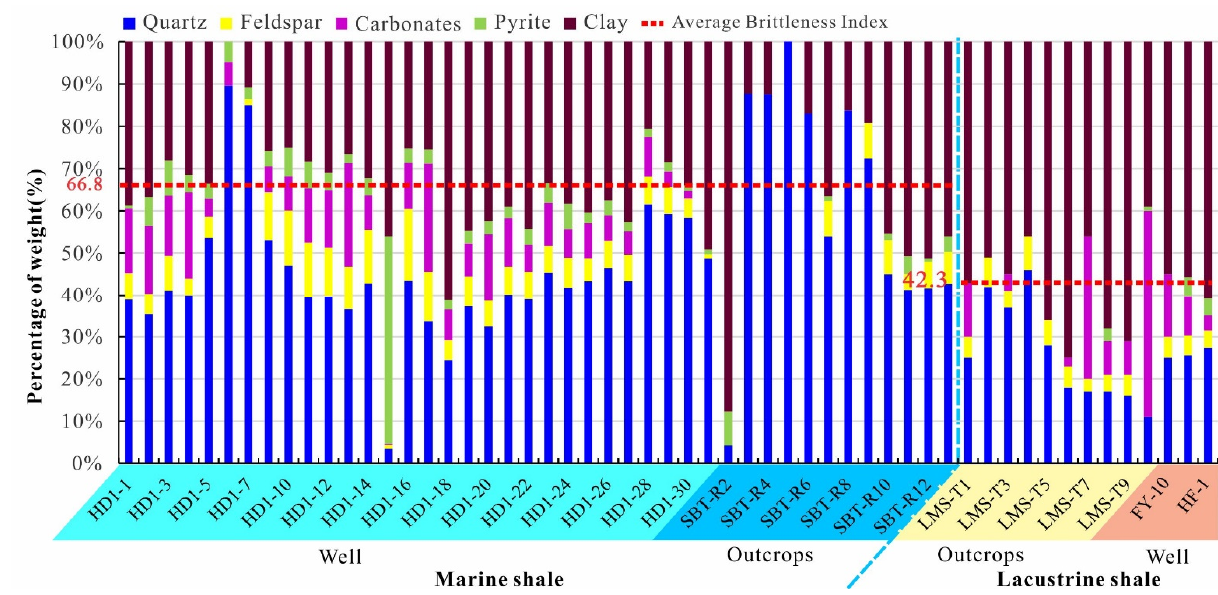
Figure 3. The mineral characteristics of the marine and lacustrine shale